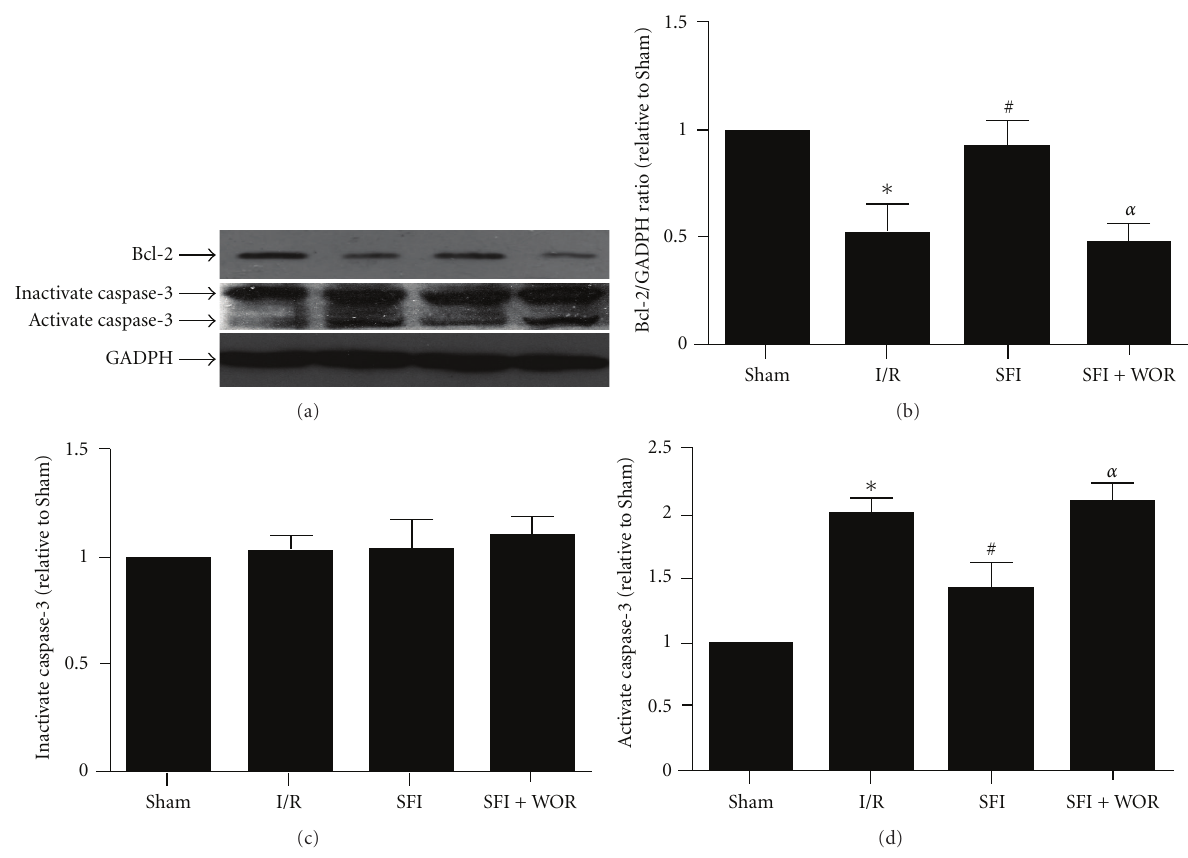
Figure 7: Immunoblots and graphs showing the protein levels of bcl-2 and caspase-3 from Sham, I/R, SFI, and SFI+WOR groups, respectively. I/R: ischemia/reperfusion; SFI: Shen-fu injection; WOR: wortmannin. Values presented are mean ± SEM. n = 6, ∗ P < . 05 versus Sham, # P < . 05 versus I/R, and α P < . 05 versus SFI.